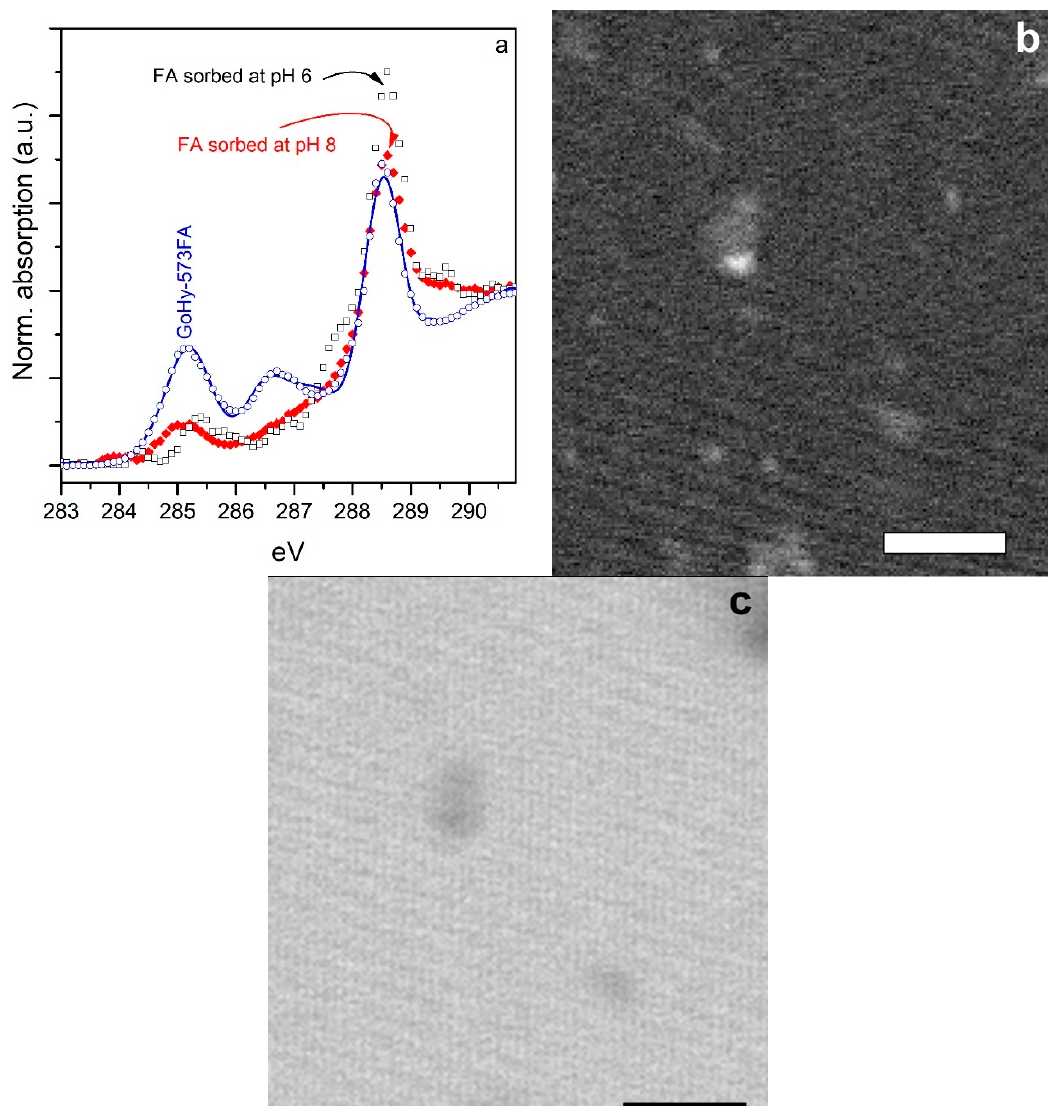
Figure 4. ( a ) Data points of measured carbon XANES spectra of GoHy-573FA starting solution prior to FEBEX bentonite sorption and spectra of organics associated to FEBEX bentonite colloids at pH 6 and pH 8, respectively. The solid line represents a best fit of the 290 eV fulvic acid spectra taking the deconvolution procedure as described in Schäfer et al. [48] and Schäfer et al. [49]. ( b ) Ratio image ( − log (I[2 85.3 eV − 295.0 eV]/I 0 [283 eV]) of organics associated with FEBEX bentonite colloids at pH 6. Brighter grey values indicate higher concentrations of organic material and show several hot spots of organic material on the clay platelets beside a homogeneous surface coverage. ( c ) STXM image taken at 283 eV below the carbon K-edge, showing absorption of bentonite colloids and aggregates. Scale bars in ( b ) and ( c ) represent 2 µm.